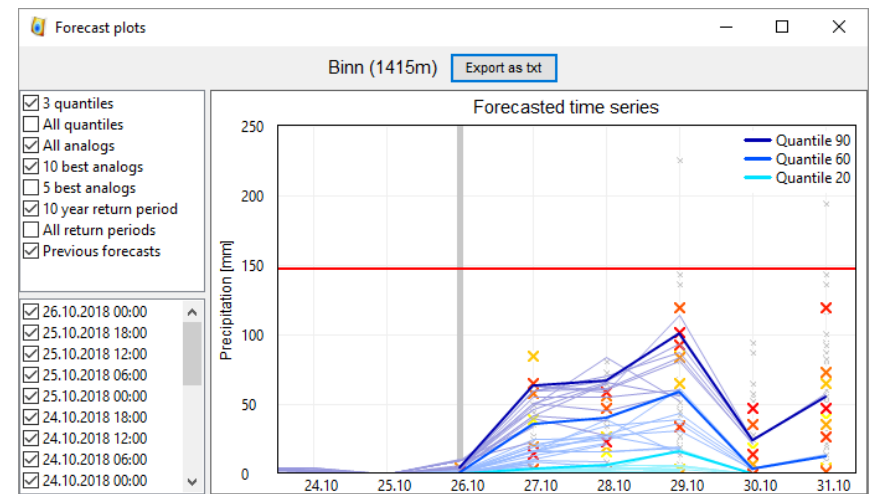
Figure 6. Visualization of the forecasted time series for an event at the Binn station (Fig. 1) in October 2018. The thick blue lines represent the 90th, 60th, and 20th percentiles for the given lead times. The thin blue lines represent the equivalent time series but from previous forecasts. The small gray crosses represent all analog values and the larger crosses highlight the 10 best analogs (with a color gradient from red for the best to yellow for the